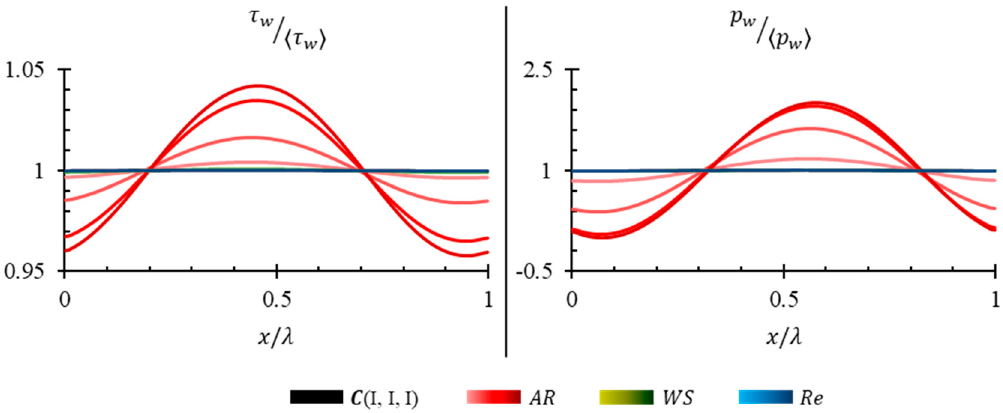
Figure 12. Influence of parameters on the normalized shear stress experienced by the top plate.